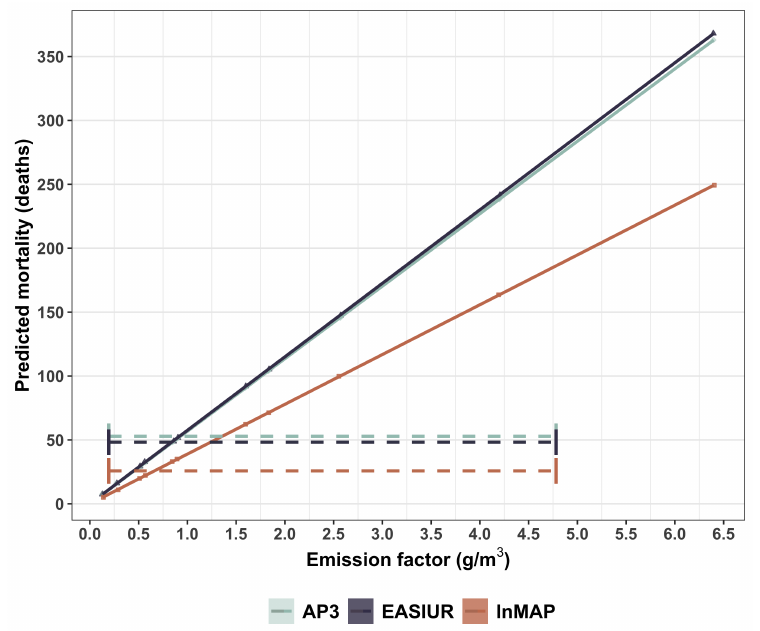
Figure 6. Sensitivity of US flaring BC mortality estimates to emission factor and model used. Hori- zontal bars reflect range of emission factors from